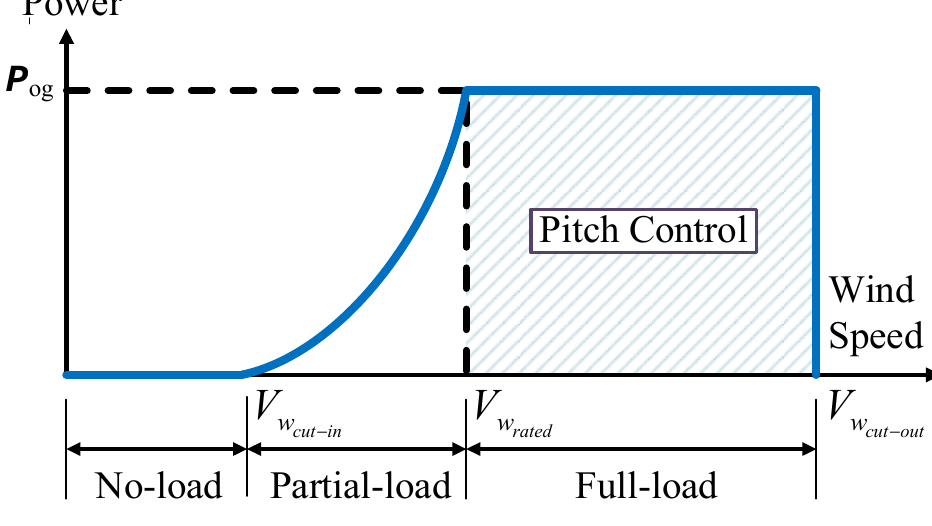
Figure 1. Ideal wind turbine (WT) power curve [34].